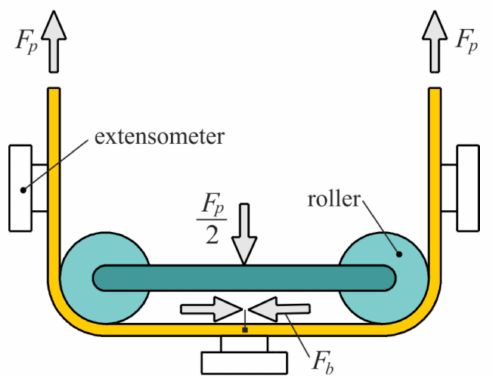
Figure 25. Schematic diagram of the tensile strip test.